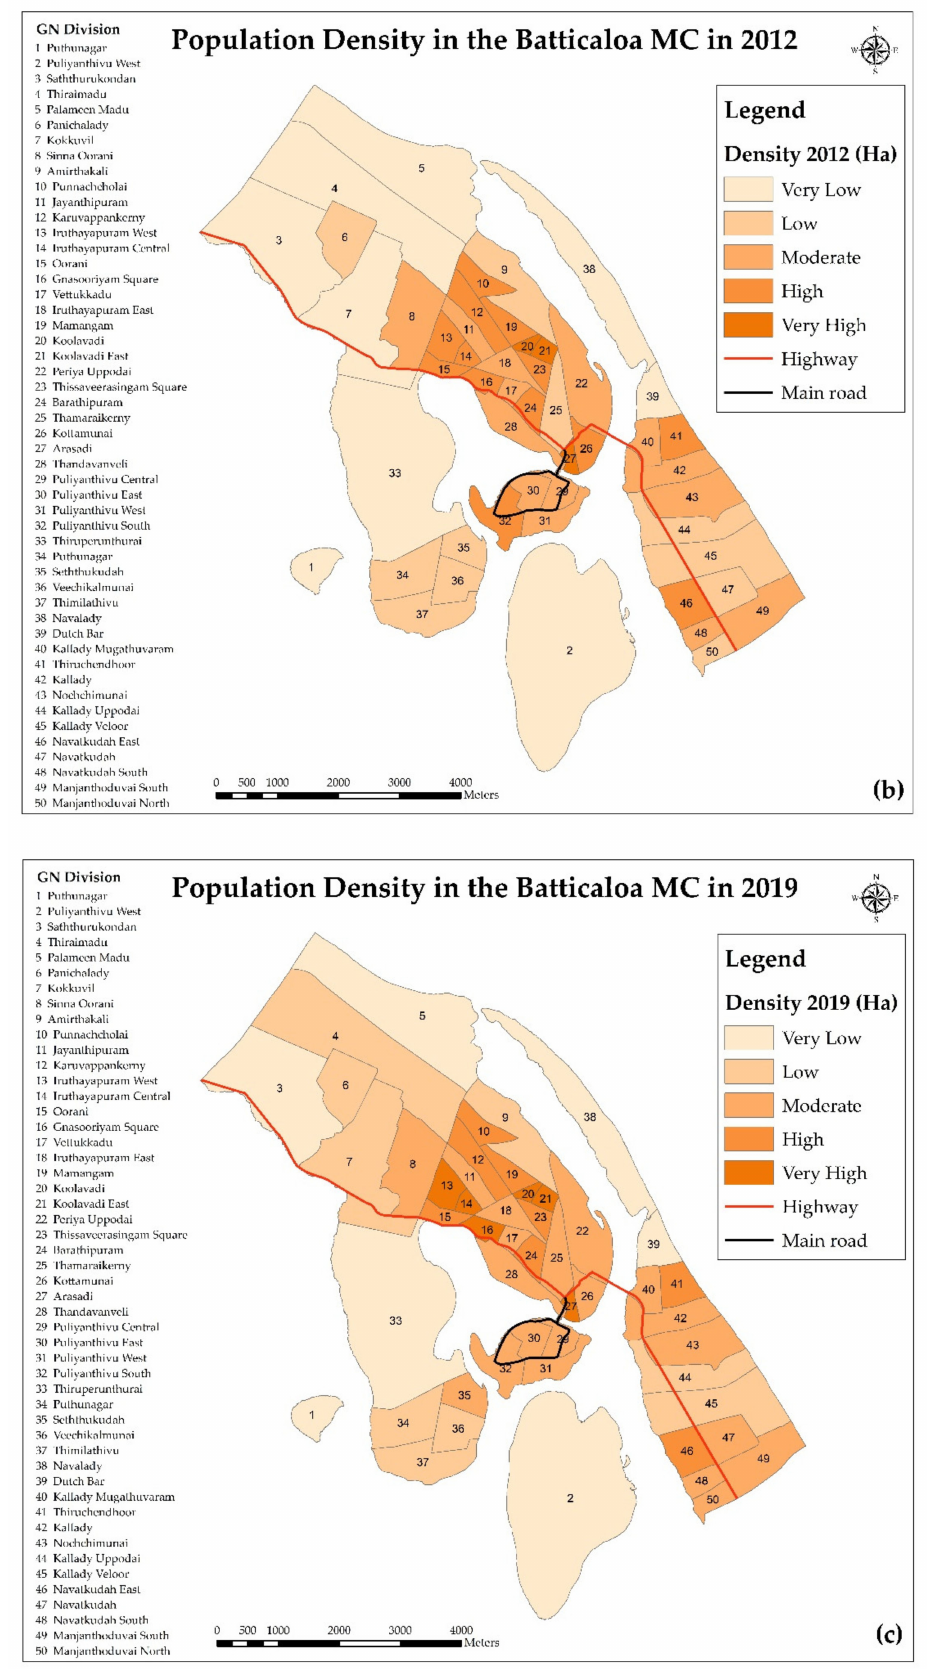
Figure 7. Population Density by Grama Niladhari Divisions in ( a ) 2001, ( b ) 2012, and ( c )